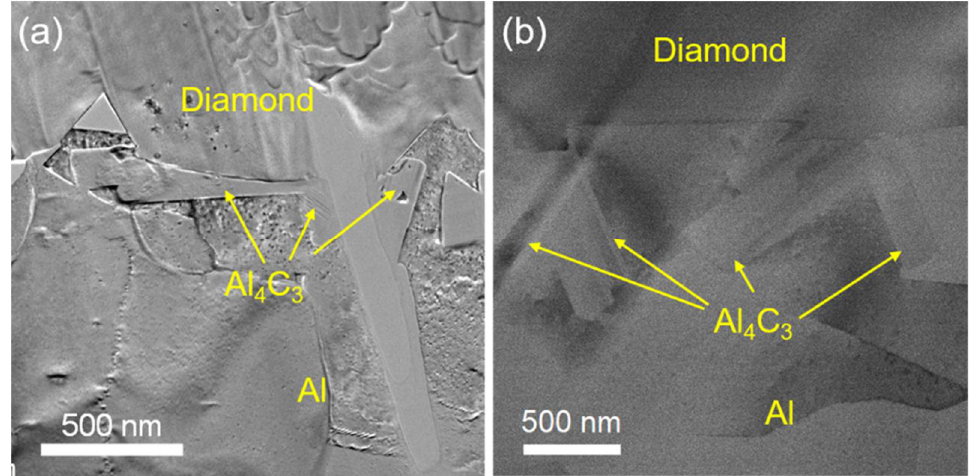
Figure 4. TEM images of the discrete in situ Al 4 C 3 at the interface in the diamond/Al composites: ( a ) diamond (100) surface and ( b ) diamond (111) surface.